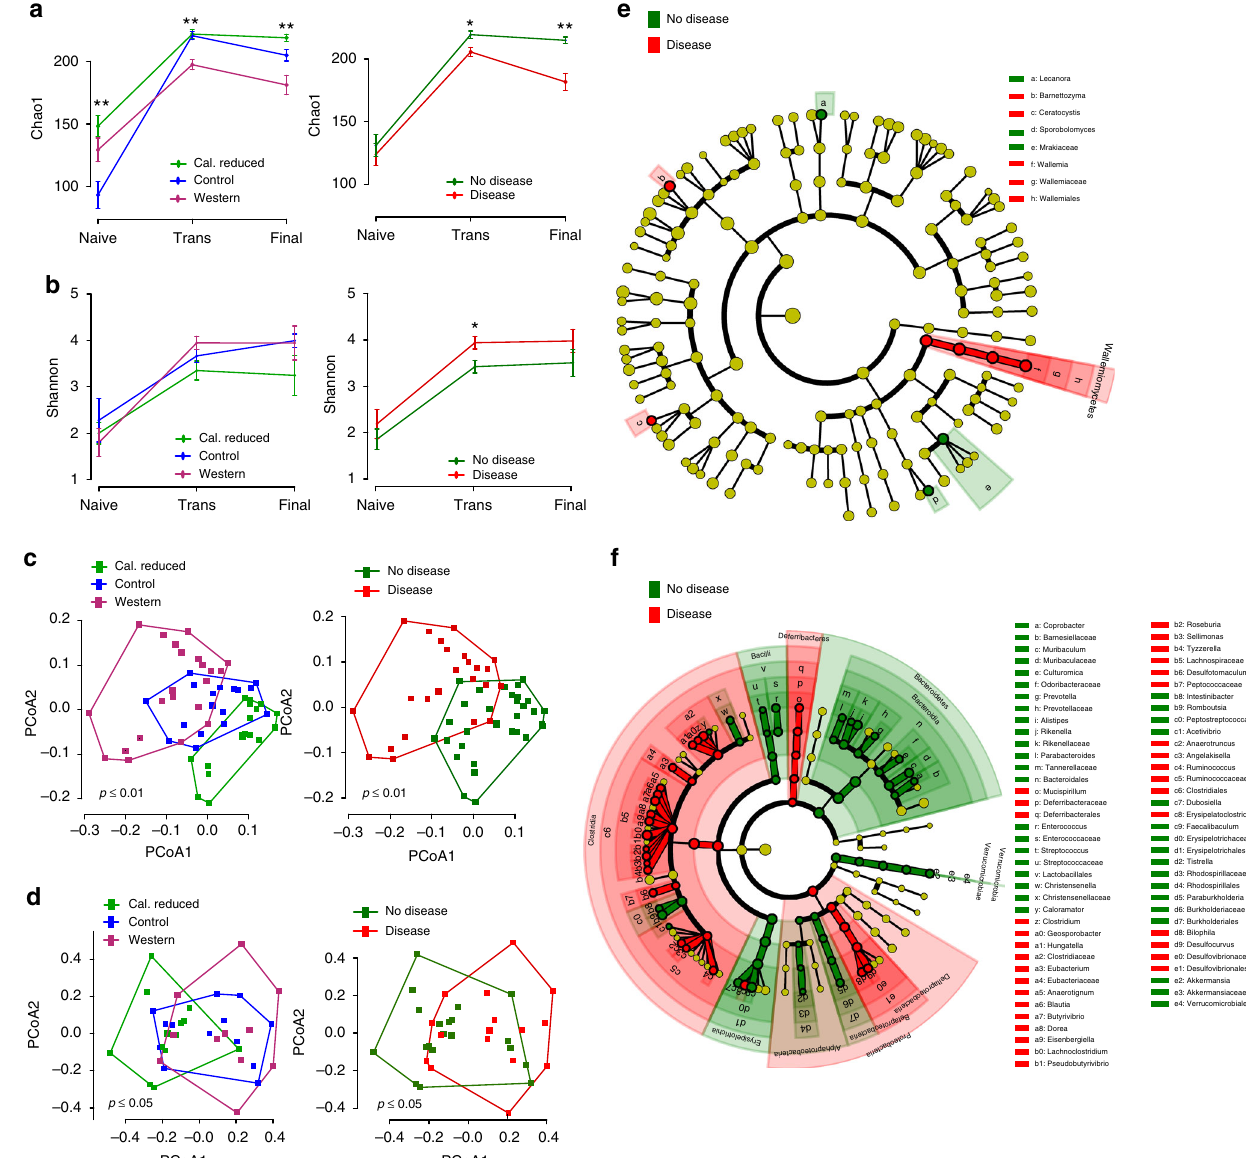
Fig. 3 Alpha/beta diversities and most differentially abundant taxa of micro- and mycobiota for classes (diet and disease) in NZM2410/J mice. a Alpha diversity (Chao1 index, species richness) of microbial species between NZM2410/J mice set on three dietary regimens across the naive, transient, and fi nal stages of disease development strati fi ed based on caloric restriction ( n = 18), control ( n = 16) or western ( n = 20) diet (left panel) or absence ( n = 31) and presence ( n = 23) of disease (right panel). b Alpha diversity (Shannon index, species richness) of the mycobiota between mice set on different diets across naïve, transient and fi nal stages of disease strati fi ed based on caloric restriction ( n = 12), control ( n = 12) and Western ( n = 10) diets (left panel) or presence ( n = 15) and absence ( n = 19) of disease (right panel). c Principal coordinate analysis (PCoA) of beta diversity for the microbiota at the fi nal stage of disease based on unweighted UniFrac distances between NZM210/J mice classi fi ed based on caloric restriction ( n = 18), control ( n = 16) or western ( n = 20) diets (left panel) or presence ( n = 23) or absence ( n = 31) of disease (right panel). d PCoA of beta diversity for mycobiota at the fi nal stage of disease based on Jaccard distances between NZM210/J mice classi fi ed based on caloric restriction ( n = 12), control ( n = 12) and western ( n = 10) diets (left panel) or presence ( n = 15) or absence ( n = 19) of disease (right panel). Differentially abundant ( e ) mycobiota and ( f ) microbiota taxa identi fi ed by the LEfSe algorithm (default parameters) at transient stage in diseased vs. non-diseased mice. In panels ( a – b ), data is presented as means± SEM and statistical signi fi cance was assessed using Kruskal – Wallis test with Mann – Whitney U test as a post hoc test. The p-values were adjusted using the Benjamini-Hochberg correction procedure. * P adj < 0.05, ** P adj < 0.01. Data in panels ( c – d ) were analyzed using the adonis function in R (permutations = 999). Source data for ( a – f ) are provided in the Source Data fi le RNA expression data generated in NZM2410/J mice, who simi- ( H2-Eb2 , Myo1f , Tap1 , Cfb , C2 , H2-K1 , Psmb9 , Psmb8 , Tnxb , larly to the AIL population harbor identical patterns of ANA Rps28 , and Col11a2 ) were shared among the above shortlisted 58 prevalence among the various diets (Figs. 2g, 5a). Based on the candidate genes (Fig. 5f). We next evaluated the RNA-Seq data presence or absence of ANA we observed 1,458 differentially after strati fi cation for diet, which is a risk factor for ANA pro- expressed transcripts (Supplementary Data 9). Of these, 11 genes duction in our study. Here, compared to the control or Western NATURE COMMUNICATIONS| (2019) 10:4097